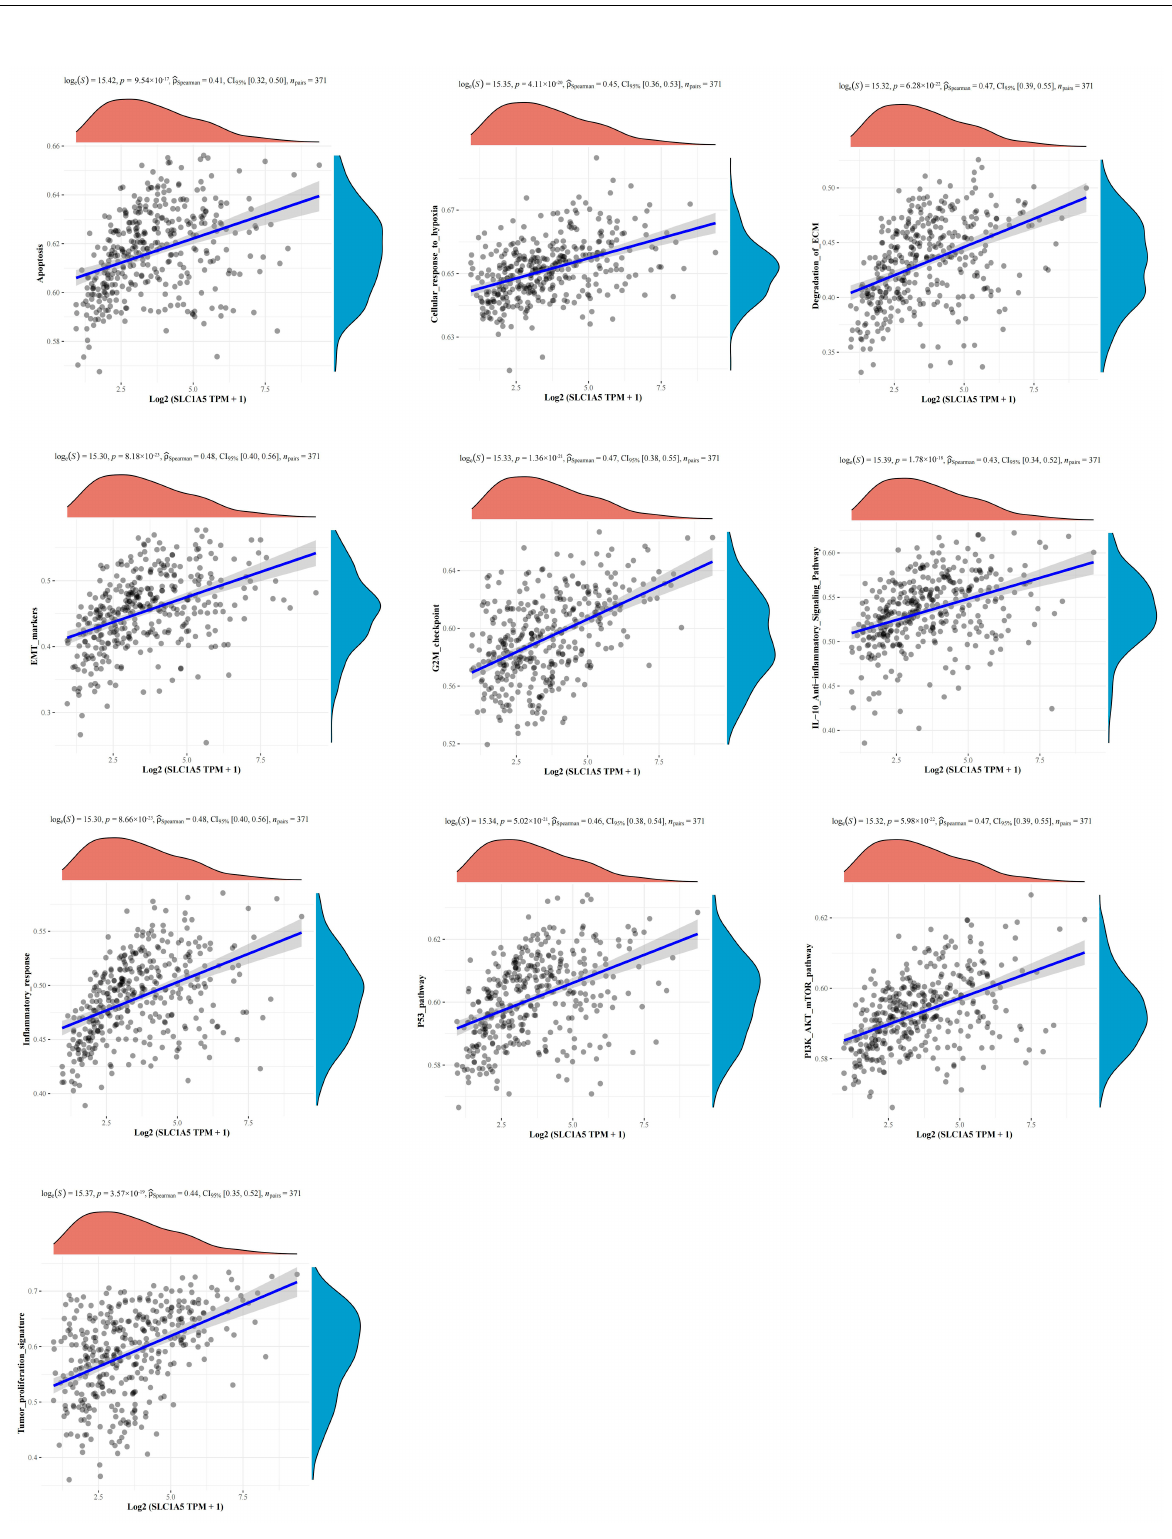
Figure 5. The correlations between the expression of SLC1A5 and pathway score analysis with Spearman. The x -axis represents the distribution of SLC1A5 expression and the y -axis represents the distribution of the pathway score. The density curve on the right represents the trend in distribution of pathway immune score, and the upper density curve represents the trend in distribution of gene expression. The values on top show the correlation p value, correlation coefficient and correlation calculation